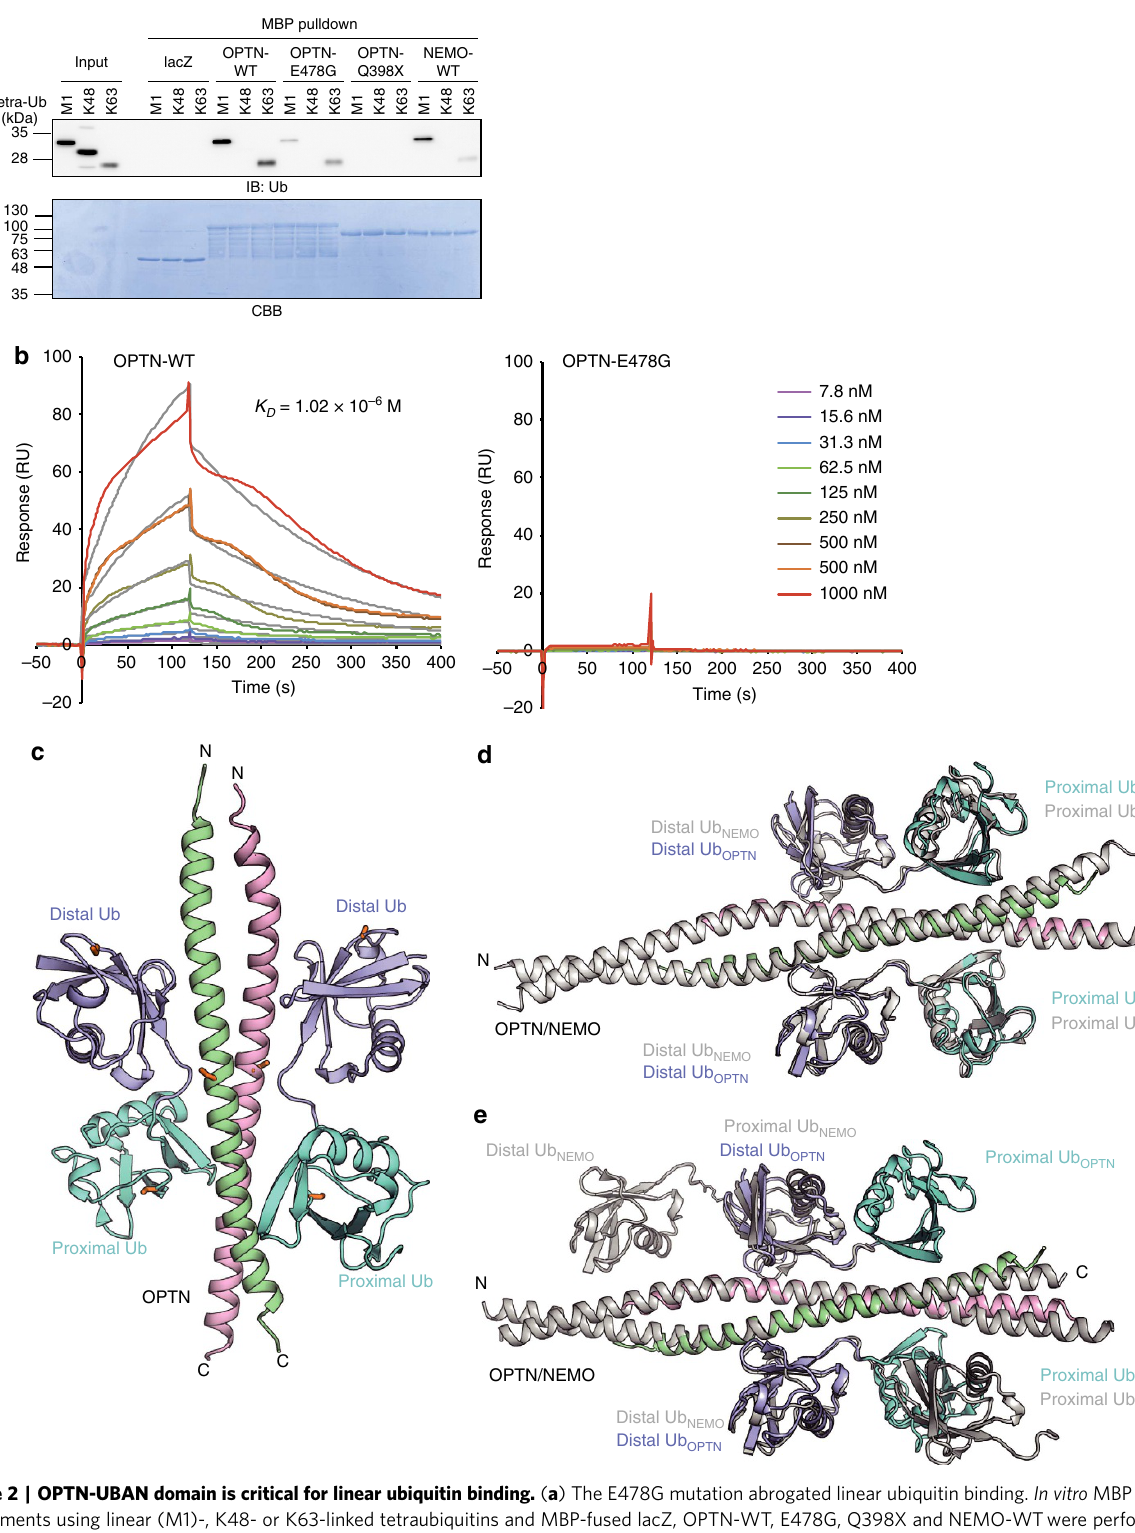
Figure 2 | OPTN-UBAN domain is critical for linear ubiquitin binding. ( a ) The E478G mutation abrogated linear ubiquitin binding. In vitro MBP pull-down experiments using linear (M1)-, K48- or K63-linked tetraubiquitins and MBP-fused lacZ, OPTN-WT, E478G, Q398X and NEMO-WTwere performed, and the bound ubiquitin chain was detected by immunoblotting. ( b ) Kinetic analyses of OPTN and linear ubiquitin. Linear tetraubiquitin was immobilized and various concentrations of OPTN-WT or E478G were tested. Grey lines, a global fit to a 1:1 interaction model. ( c ) Crystal structure of OPTN-UBAN in complex with linear diubiquitin (crystallized in the presence of linear tetraubiquitin). Each subunit of OPTN is coloured green and pink, respectively. The distal and proximal ubiquitin moieties are coloured purple and cyan, respectively. Phosphorylation sites, such as Ser65 in ubiquitin and Ser473 in OPTN, are coloured orange. ( d ) Superimposition of the structures of OPTN (cid:4) linear diubiquitin and NEMO (cid:4) linear diubiquitin (grey) (PDB 2ZVN). ( e ) Superimposition of the structures of OPTN (cid:4) linear diubiquitin and NEMO (cid:4) K63 diubiquitin (grey) (PDB